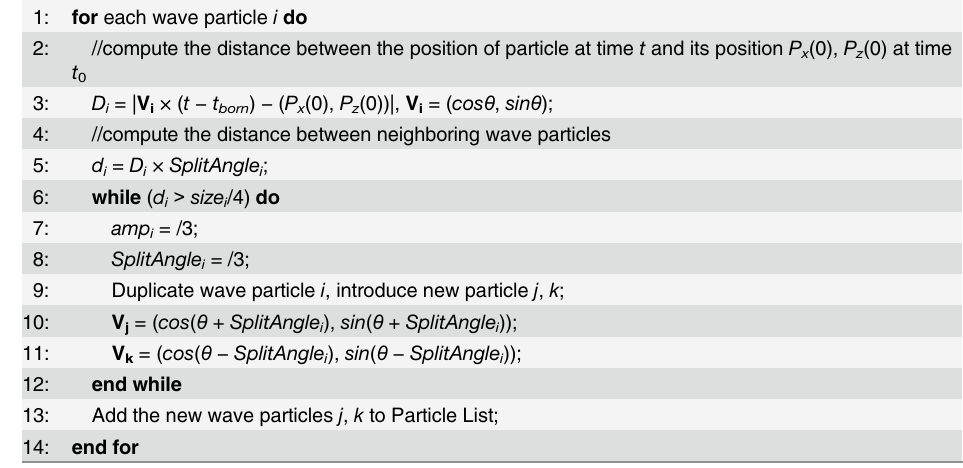
Table 1. Algorithm 1: Splitting of wave particles.